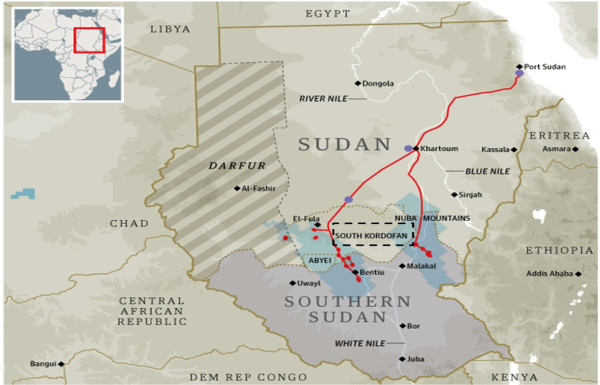
Location of the study area.